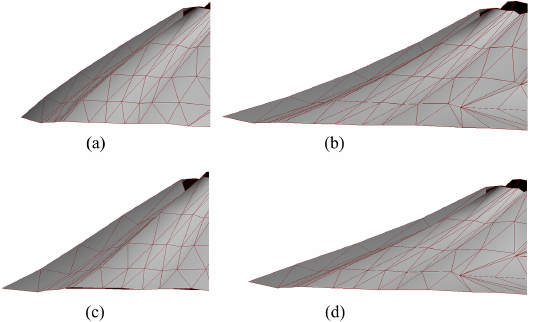
Figure 18. The sides generated by different side line generation coefficients: ( a ) Convex side, with one control point and bending coefficient 0.5; ( b ) concave side, with one control point and bending coefficient 1.5; ( c ) upper convex and lower concave, with two control points and bending coefficients 0.5/1.5; ( d ) upper concave and lower convex, with two control points and bending coefficients